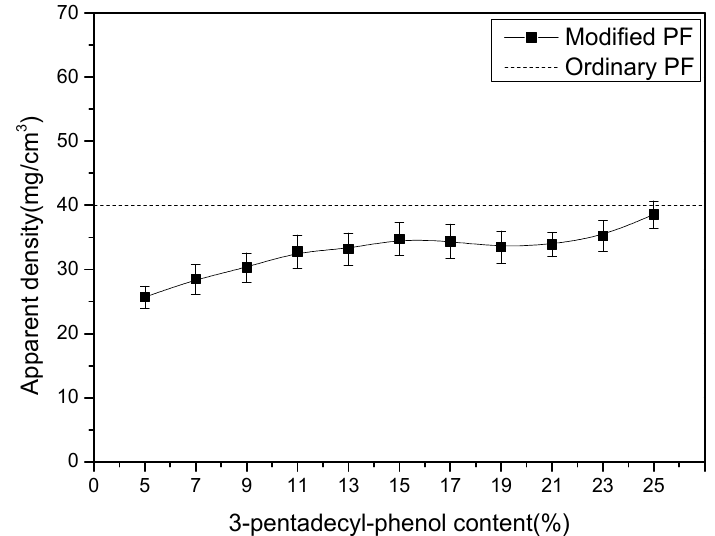
Figure 9. The effect of 3-pentadecyl-phenol with different contents on the apparent density of the foam. As 3-pentadecyl-phenol increases, the toughness of the phenolic foam, the toughness of the foam wall becomes better and the cells are not easily broken after the addition of the foaming